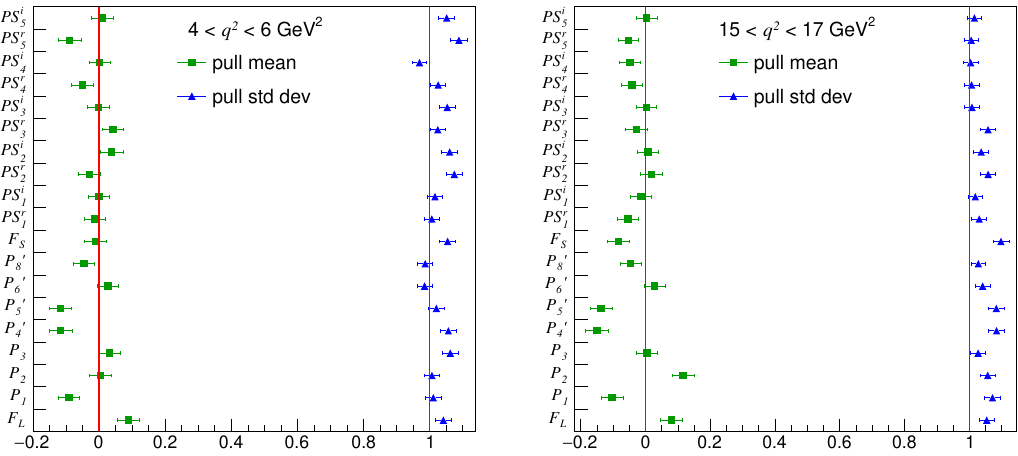
Figure 10 . Summaries of the (green) means and (blue) standard deviations of the pull distribution for the optimised P-wave observables and optimised S-wave observables, PS i , in two bins of q 2 . The red lines are references at 0 and 1.